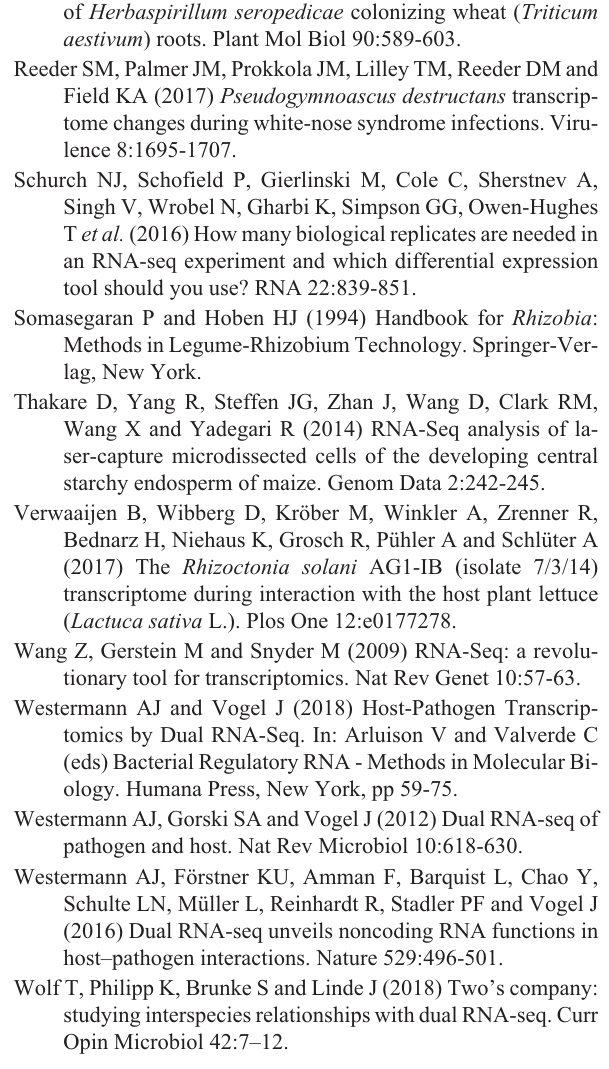
Figure S1 - Filtering procedure and construction of the Chi- mera library. Figure S2 - Mapping strategies to determine the number of cross-mapping reads. Figure S3 Step-by-step of how to extract the reads after the mapping step using the Combined Reference in the CLC workbench environment. Table S1 - Matrix indicating the reads from (A) Z. mays or (B) Herbaspirillum that were used to determine the true positive (TP), true negative (TN), false positive (FP) and false negative (FN). Table S2 - Library features and number of total reads attrib- uted to the Herbaspirillum seropedicae or Zea mays geno- mes according to the mapping approach. Table S3 - Comparison of the number of reads and where these reads were mapped in each reference genome with